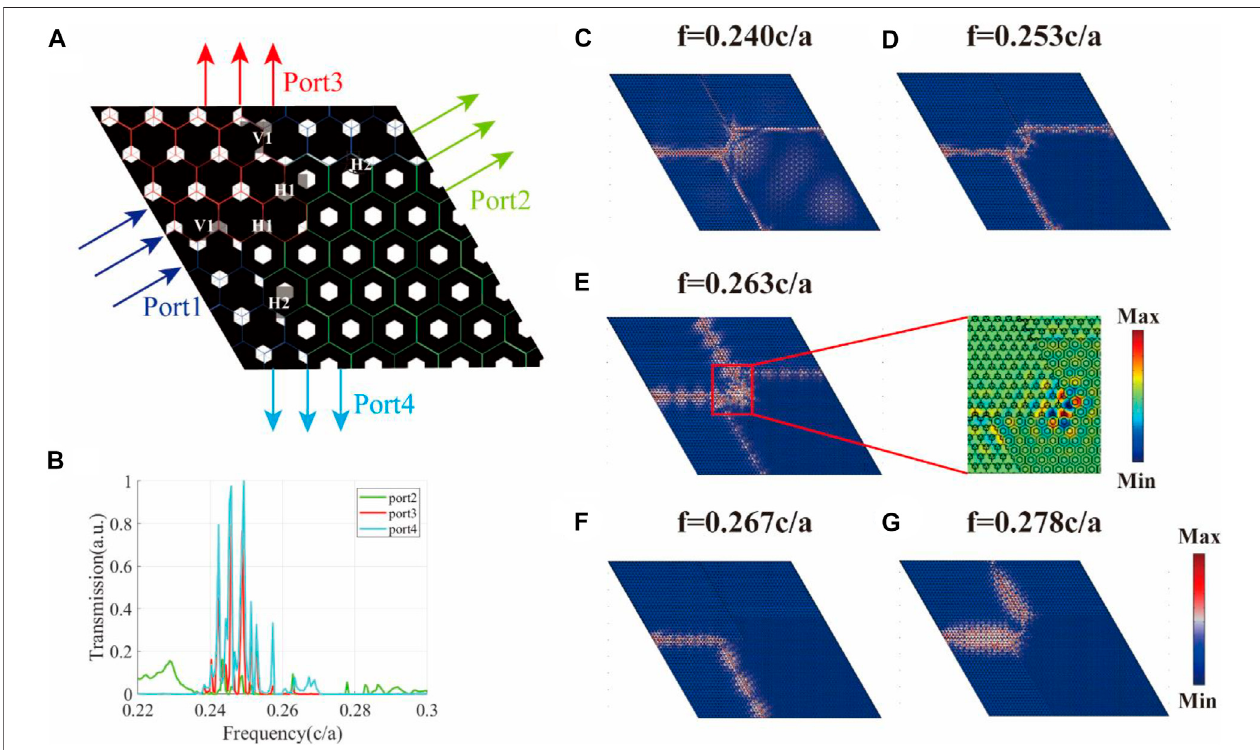
FIGURE 4 | Design of a four-port routing platform based on topological photonic crystals. (A) Schematics of the multiport topological routing platform. There are four domains on the platform constructed by PC1, PC2, and PC3. The boundaries of these different topological photonic crystals introduce three different edge states (V1, H1, and H2) and two corner states (H1 type) at the intersection point. (B) Transmission spectrum of the four-port device when light is incident from port 1. The transmissionintensityofdifferentpaths obviouslyvaries withfrequency. (C – G) Electric- fi eld intensitydistributionsat thefrequencies0.240 c/a ,0.253 c/a , 0.263 c/a , 0.267 c/a ,and0.278 c/a ,respectively.Theinsetofpanel (E) showstherealpartof H z fi elddistributionatafrequencyof0.263 c/a ,indicatingtheexcitationoftheH1-typeII corner state. Through the frequency-dependent selective excitation of different types of topological boundary states, such a four-port device provides a novel way to route the optical transport with topologically protected